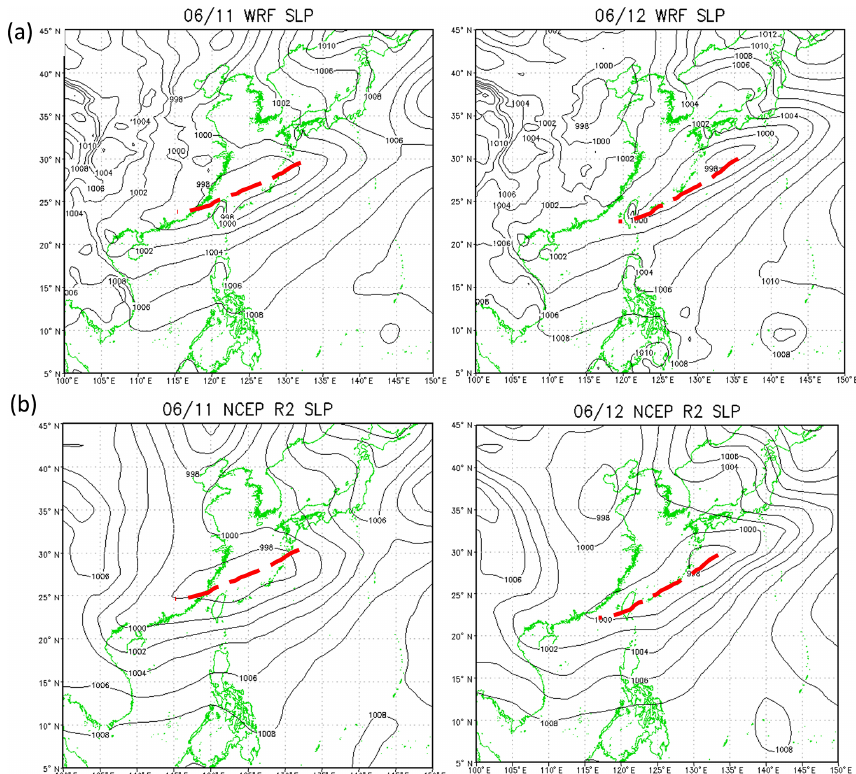
Figure 6. Comparison of (a, b) simulated sea level pressure (hPa) with (c, d) the NCEP reanalysis data at 08:00LT on 11 June (a, c) and 12 June (b, d) 2012. Frontal position is indicated by the red dashed lines.